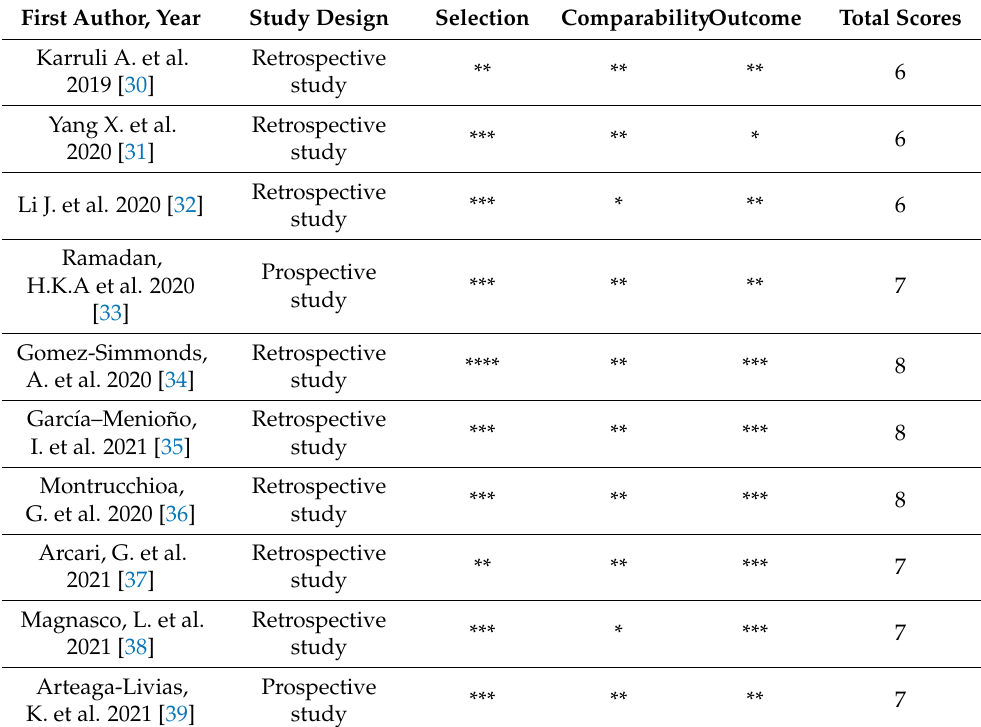
Table 2. Quality assessment of the included studies by the Newcastle–Ottawa